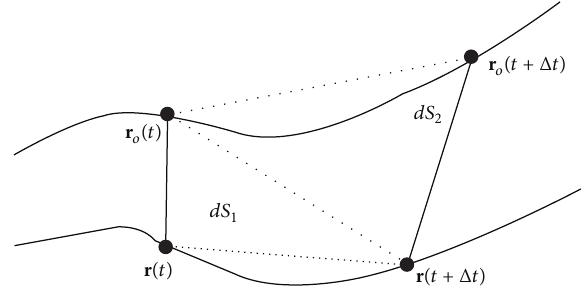
Figure 1: The area element between r (𝑡) and r 𝑜 (𝑡)